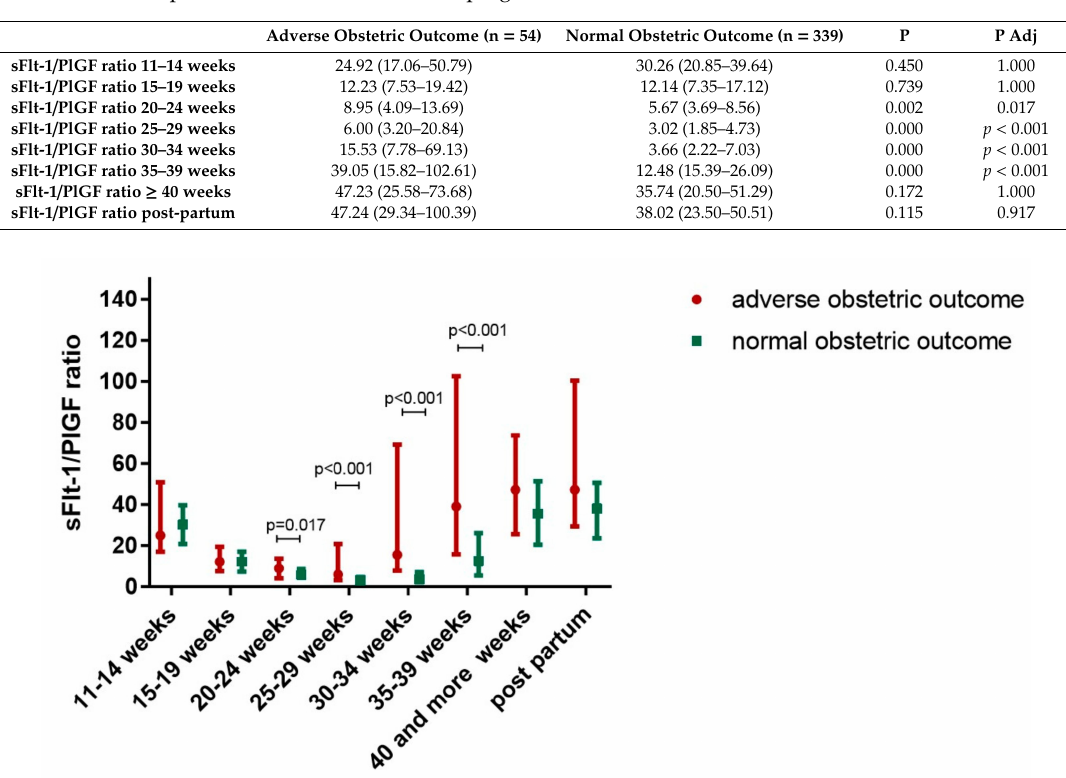
Table 2. Longitudinal changes of sFlt-1 / PlGF ratio during pregnancy in women with adverse obstetric outcome compared to women with normal pregnancies.